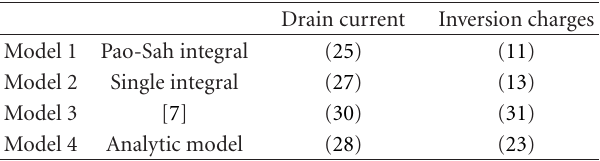
Figure 7: The di ff erent drain currents I D versus Vg from models (1 − 4). (A): in the vicinity of the threshold voltage V T 0 . Table 1: Analytic models.